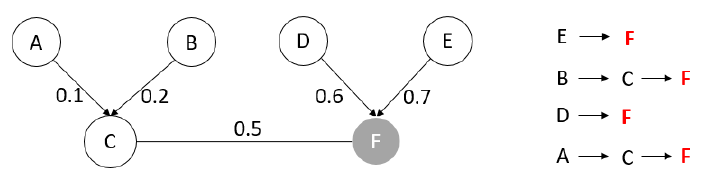
Figure 7. Root cause identification with weight